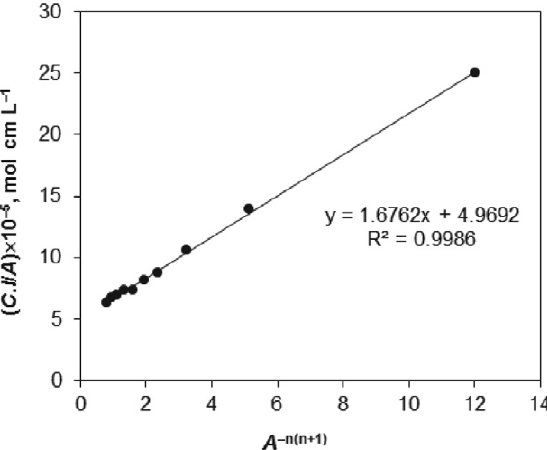
Figure 7. Dependency of ( C.l/A ) on A ‒n/(n+1) (method of Komar– Tolmachev) C = C Mо(VI) mol L –1 ; C TTC = 2 C Mo(VI) mol L –1 ; C 3,5-DNC =